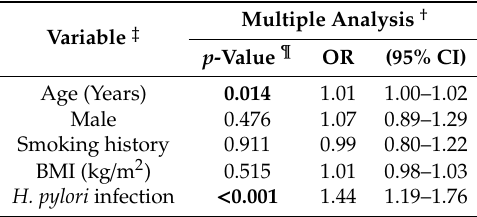
Table3. MultivariatelogisticregressionanalysisforindependentpredicatorsofhighserumCA72-4level.